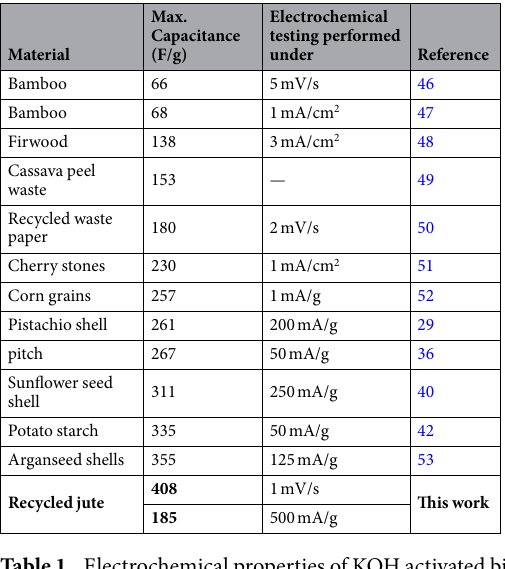
Table 1. Electrochemical properties of KOH activated bio-mass.